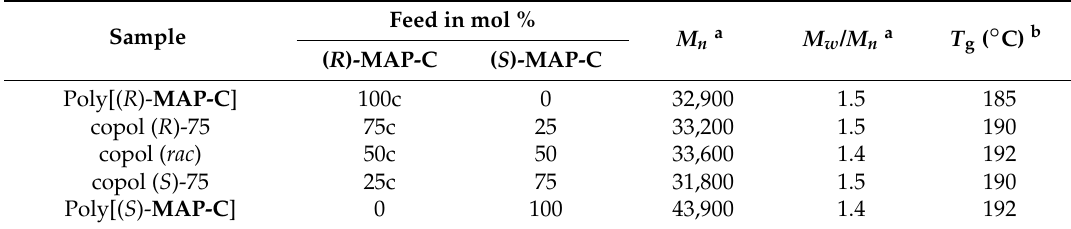
Table 3. Characterization of polymeric